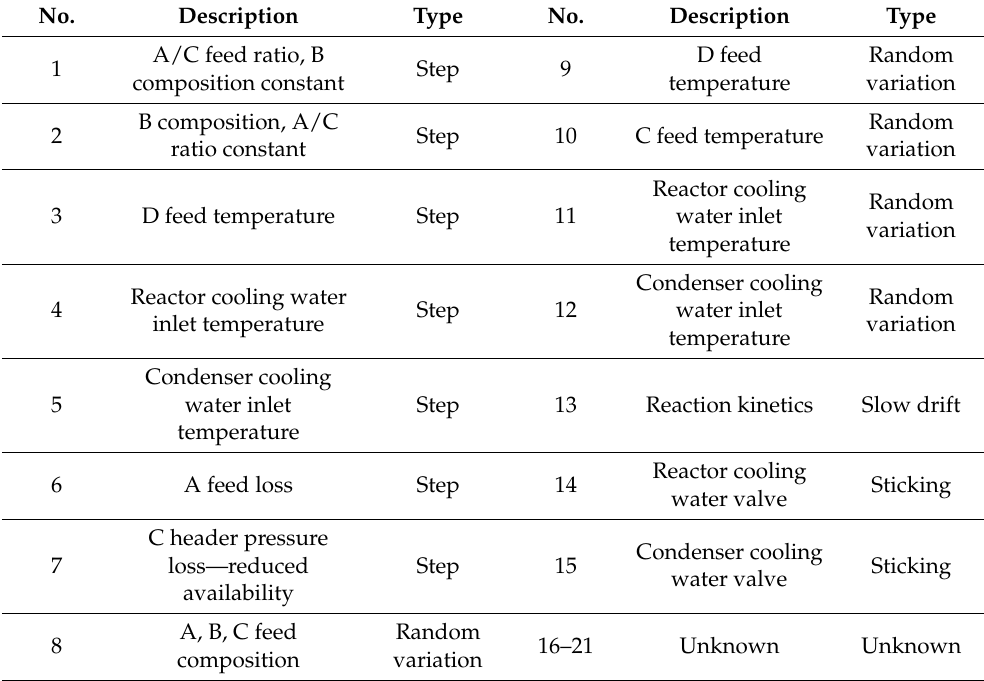
Table 4. Fault descriptions for the Tennessee Eastman (TE) process.